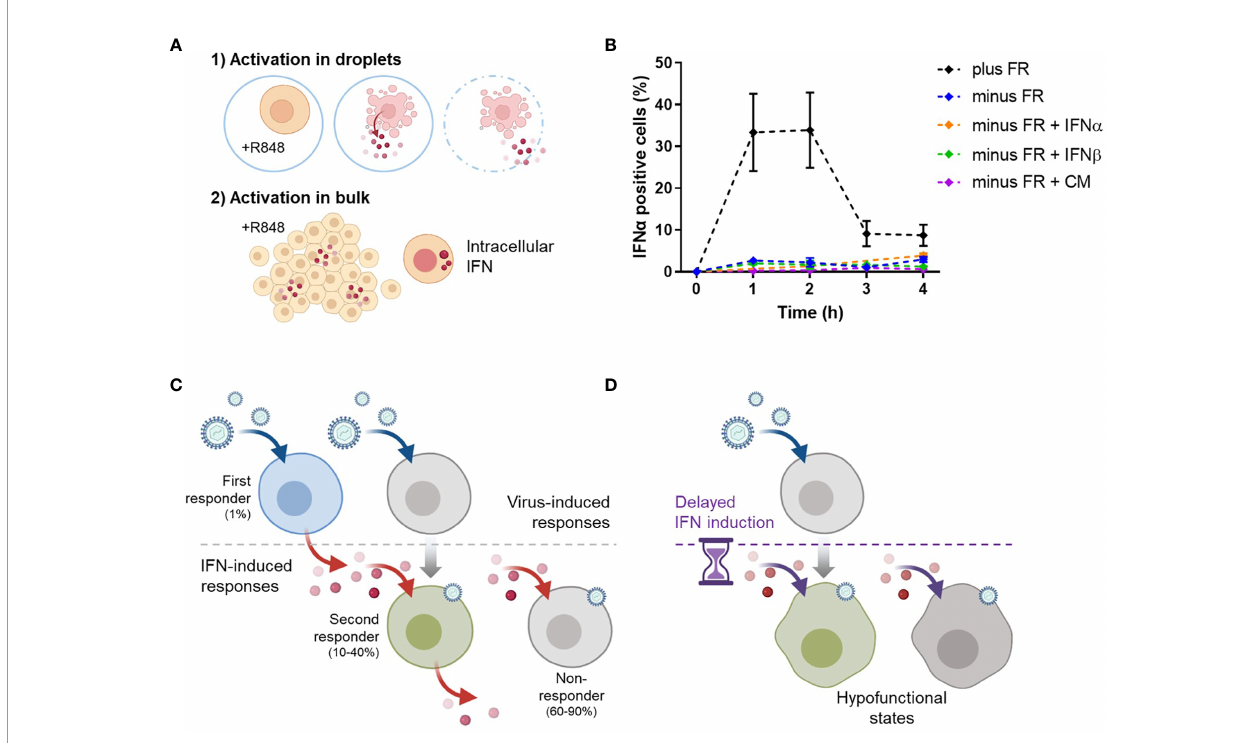
FIGURE 6 | Timing of IFN-I dynamics is key for orchestrating population-wide IFN-I responses. (A) Freshly isolated pDCs were either only activated in bulk with 5 m g/mL R848 (2) or fi rst activated in droplets with 50 m g/mL R848 (1), followed by the activation in bulk (2). In theory, activation 1) leads to the eradication of fi rst responders (minus FR), whereas activation 2), without prior activation 1), will still include the fi rst responders (plus FR). Next, cells were fi xed, permeabilized and stained for intracellular IFN a over the course of the fi rst 4 hours after bulk activation (2). (B) Depicted are the dynamics of IFN a positive cells per condition. The additives IFN a (100pg), IFN b (250pg), and conditioned medium (CM, 100%) were added upon activation 2). Dots represent mean percentages; error bars represent SEM, n = 6. (C) Schematic overview of proper IFN-I induction by a small fraction of fi rst responders, induced upon viral detection. Subsequently, the secreted IFN-Is induce the larger fraction of second responders, which arise from the population that did not became a fi rst responder in the earlier phase. The majority is left unresponsive. (D) Without the proper timing of the IFN-induced responses by the fi rst responders, pDCs will enter a hypofunctional state, as observed in panel (B)